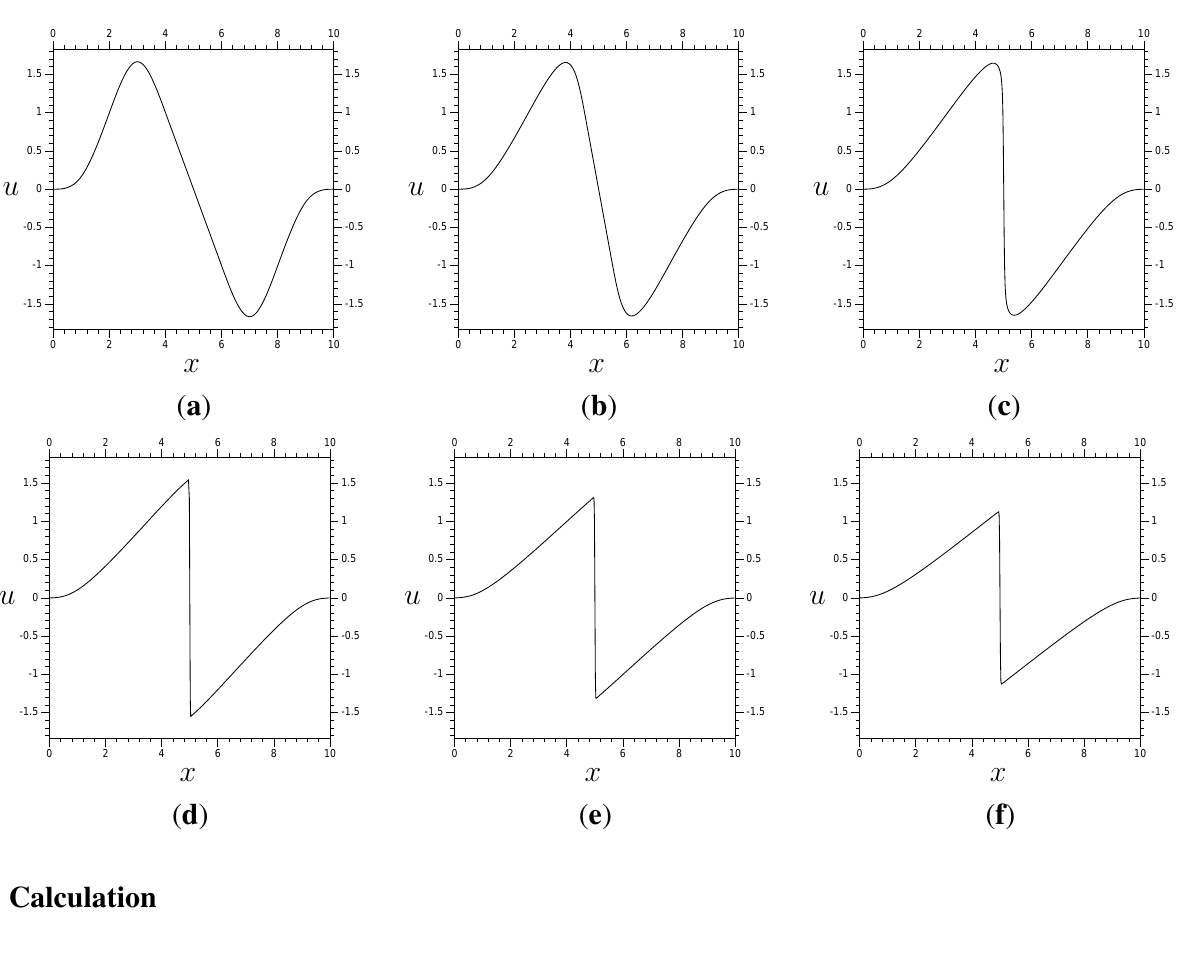
resolution and time step h = 0 . 01 6